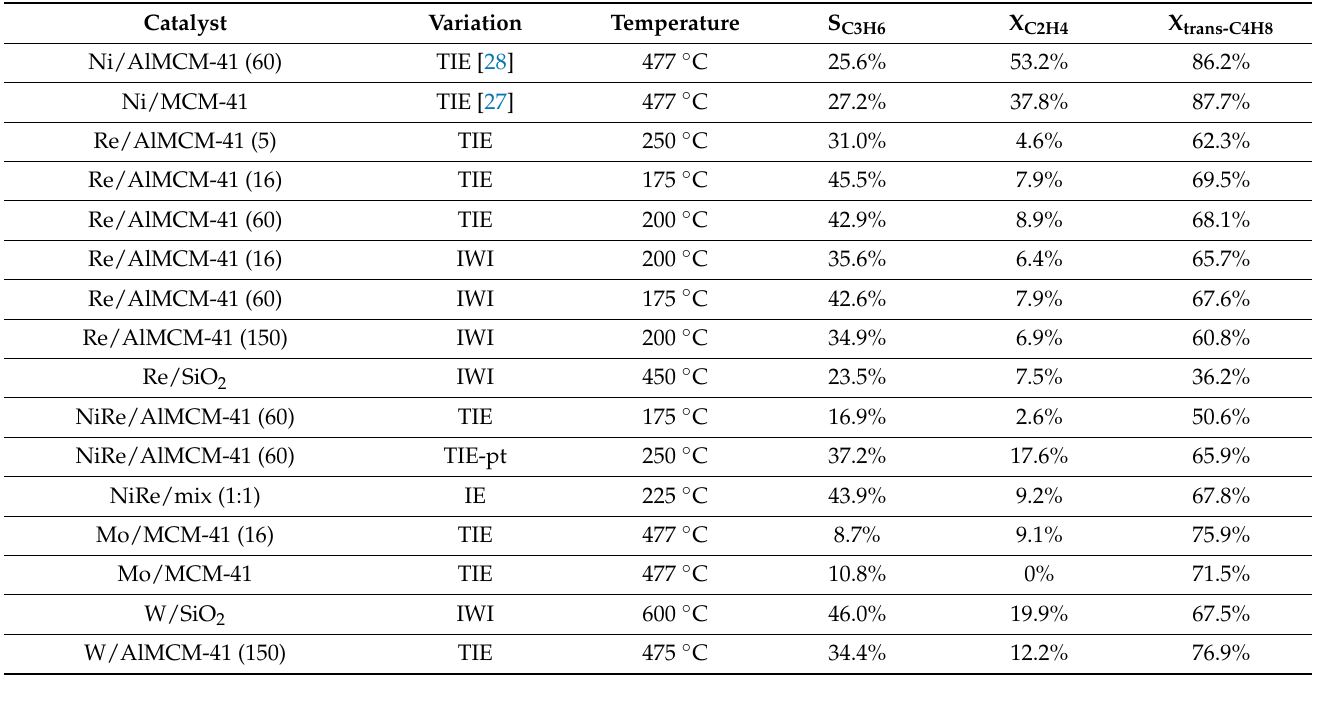
Table 1. Activity results of selected suitable metathesis catalysts for varying temperatures with an equimolar feed of 2.5% of ethene and 2.5% of trans-butene.